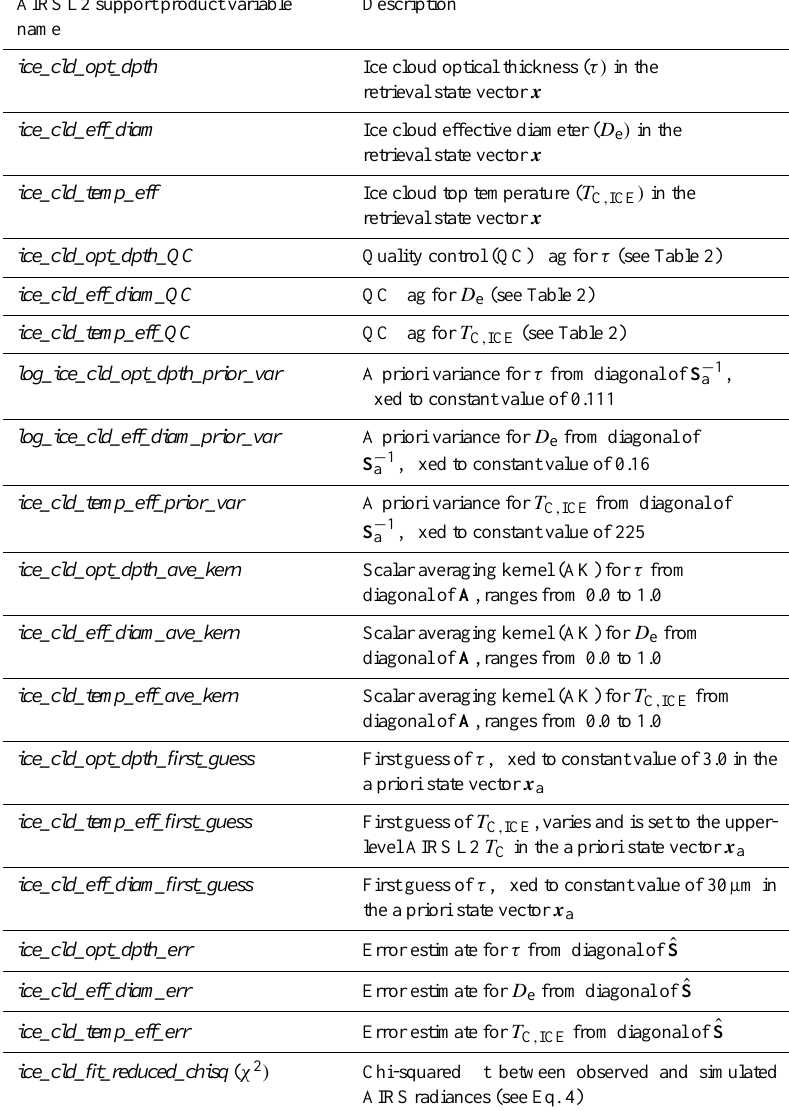
Table 3. Names and descriptions of all ice cloud retrieval parameters found in the AIRS L2 support product files.